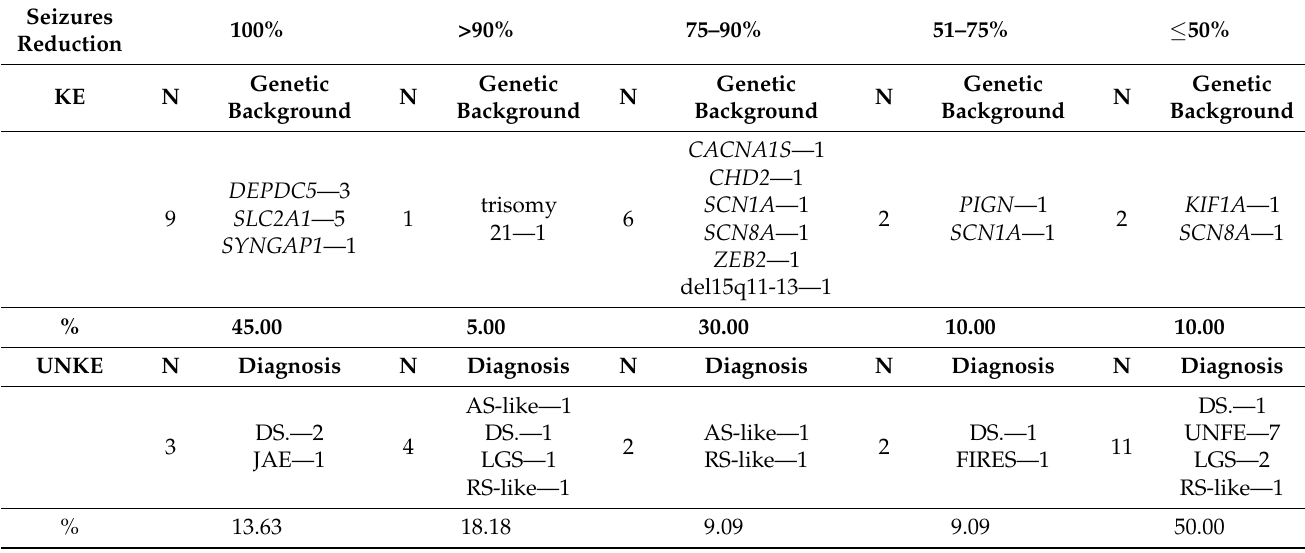
Table 2. Efficacy of the ketogenic diet treatment depending on the recognized genetic background or symptomatic